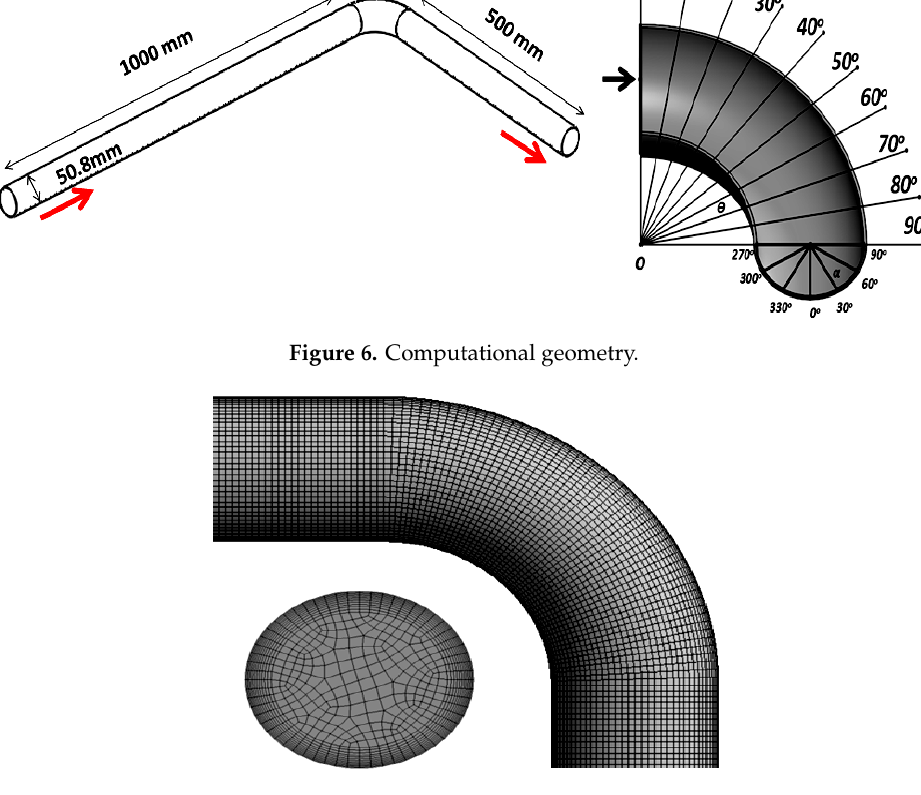
Figure 7. Computational mesh. Table 3. Mesh independence statistics.